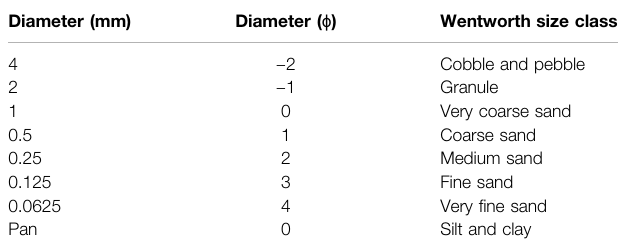
TABLE 2 | Selected sieve sizes based on grain-size classi fi